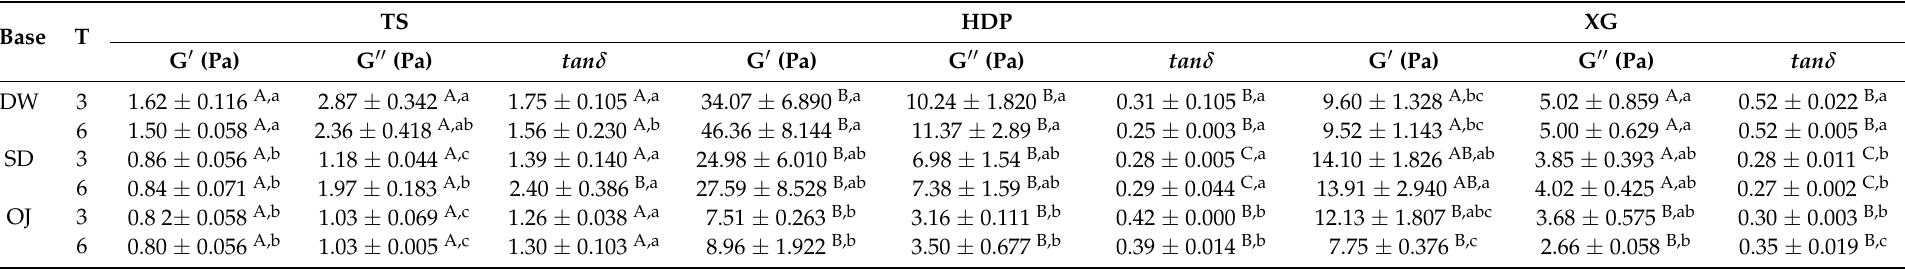
Table 6. Storage modulus (G (cid:48) ), loss modulus (G (cid:48)(cid:48) ), and loss tangent ( tan δ ) affected by different combinations of holding times (T in minutes), commercial thickeners, and aquatic continuous phases at 1